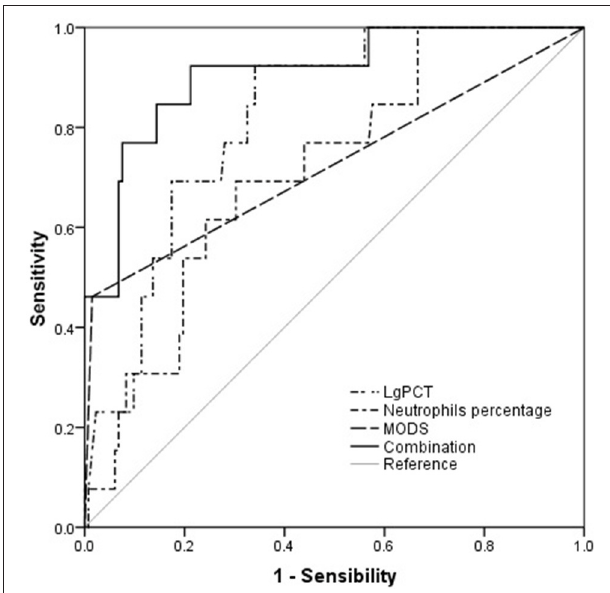
FIGURE 3 | Procalcitonin (PCT) and the percentages of neutrophils at admission and the occurrence of multiple organ dysfunction syndrome (MODS) in predicting the prognosis of hemorrhagic fever with renal syndrome (HFRS) patients by receiver operating characteristic curve (ROC)